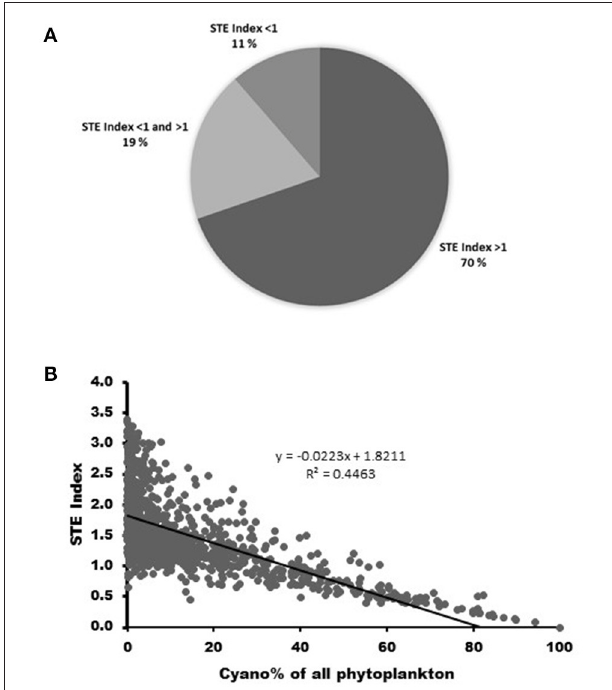
FIGURE 3 | (A) The proportions of sterol sufficient (STE index > 1), occasionally sterol limited (STE index < 1 and > 1) and permanently sterol limited (STE index > 1) lakes in boreal and sub-arctic area (based on dataset of 9 057 phytoplankton samples from 907 lakes). (B) Sterol limitation (STE index < 1) occurs in lakes where ≥ 40% of the phytoplankton biomass consisted of